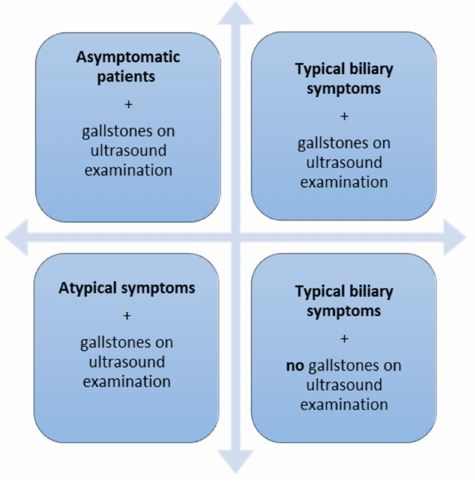
Figure 4. Presentation of women patients with